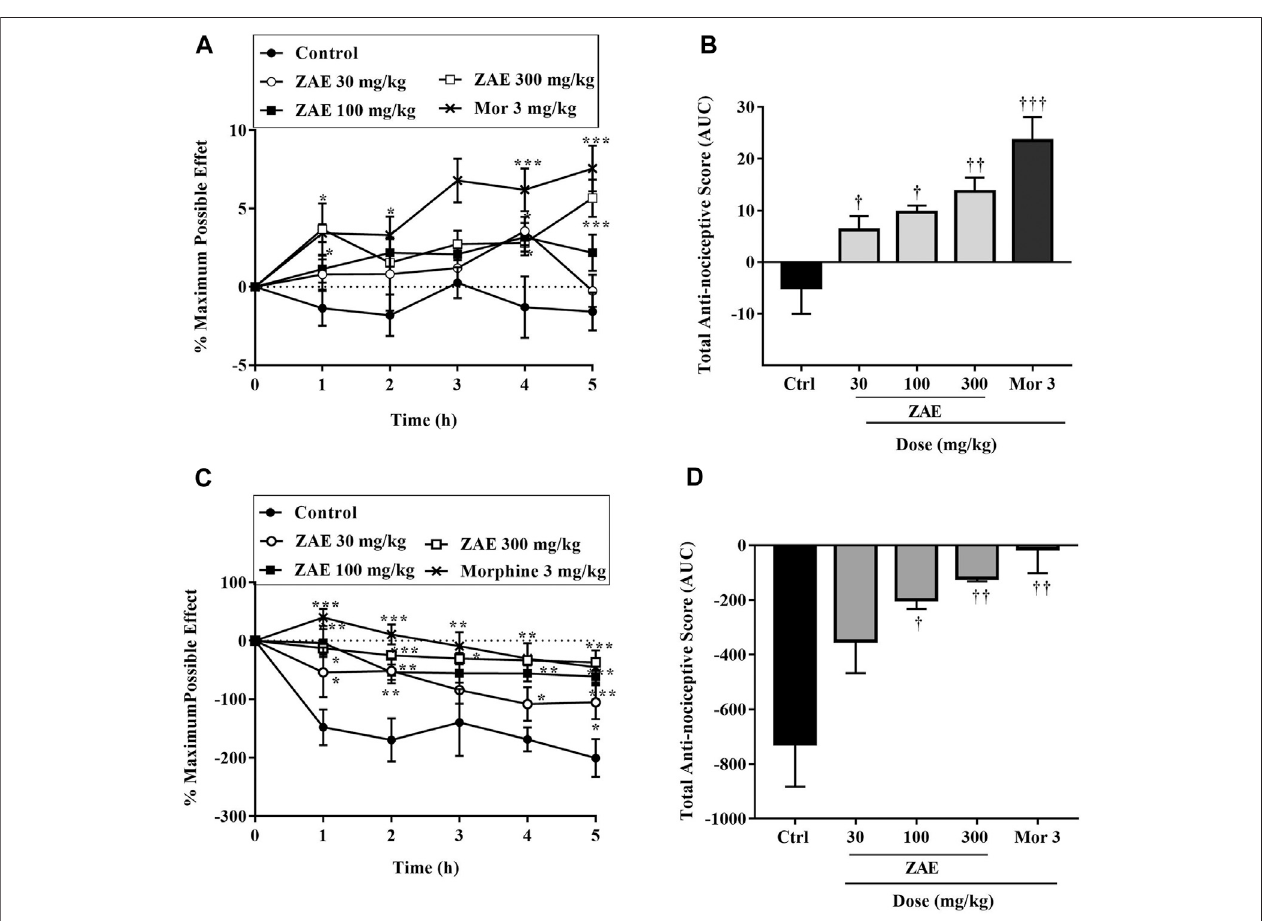
FIGURE 5 | Effect of pre-treatment of rats with ZAE and morphine on TNF- α (A, B) and IL-1 β (C, D) - induced hyperalgesia. Data (A and C) represent the time- course curves whereas (B and D) represent total anti-nociceptive effects (AUC). The symbols * p < 0.05; ** p < 0.01; *** p < 0.001 denote signi fi cant differences in time- course curves oftreatment compared tothe control (Ctrl) group (two-way ANOVA followed byDunnet ’ smultiple comparison test) whereas † p < 0.05, †† p < 0.01, ††† p < 0.001 denote signi fi cant differences of treatment in comparison with control (Ctrl) group using the one-way ANOVA followed by Tukey ’ s multiple comparison test.